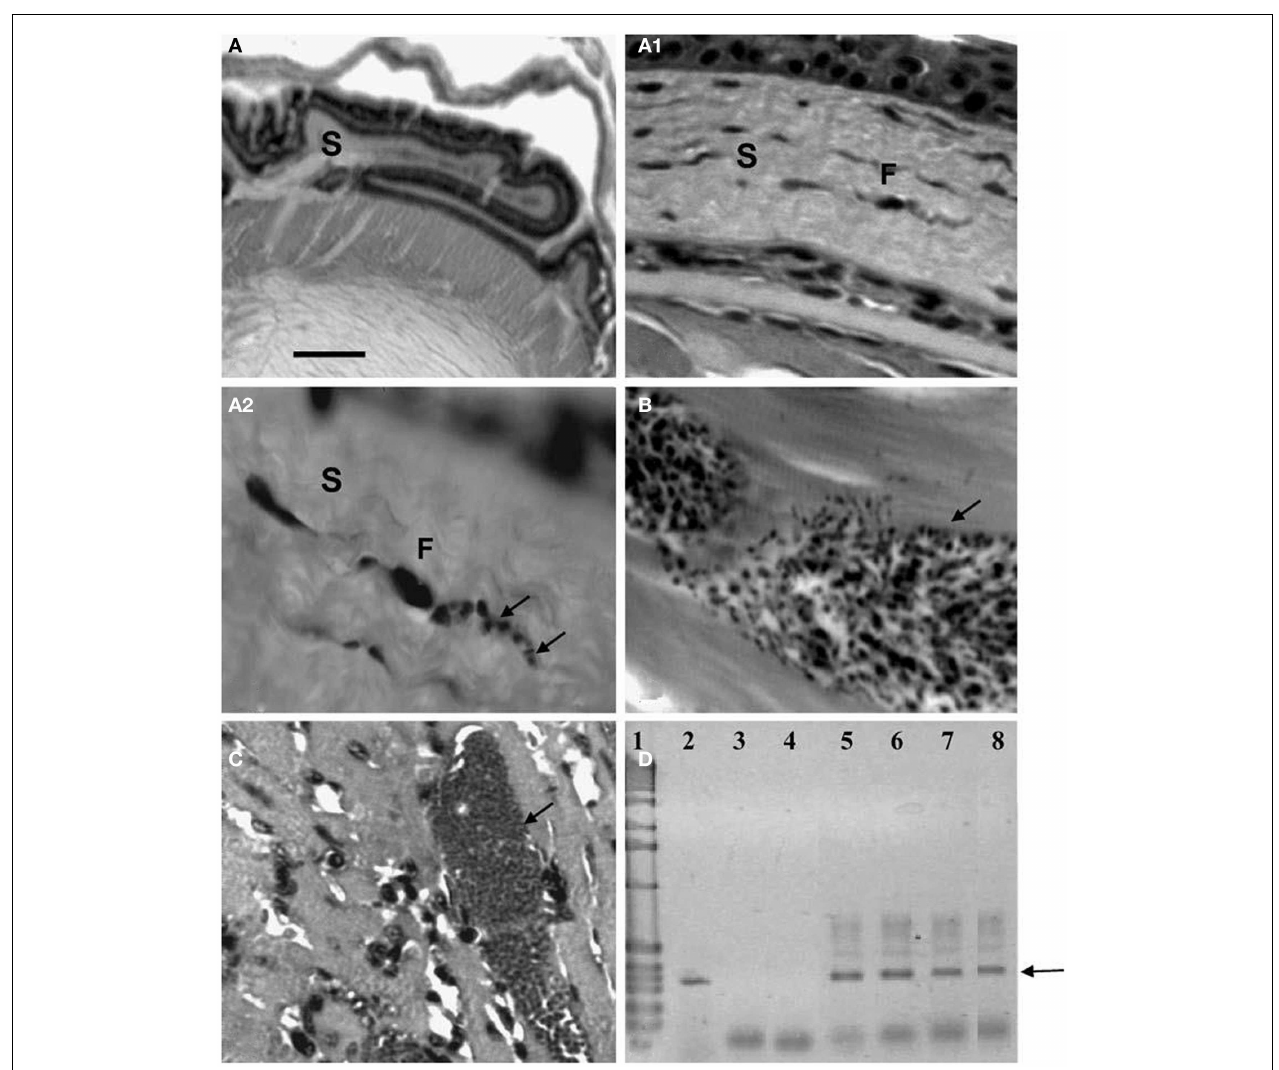
kDNA (arrow) extracted from ocular tissues of experimentally infected NMRI mice in 2.5% agarose gel electrophoresis (ethidium bromide stain): Lane 1 1-kb ladder molecular marker (Gibco BRL LifeTechnologies), lane 2 nude T. cruzi DNA, lane 3 negative PCR control, lane 4 MRAT/VE/1996/CO22 isolate, lane 5 MHOM/BR/1950/Y strain, lane 6 MHOM/VE/1970/EP isolate, lane 7 MDID/BR/1999/M1 isolate, and lane 8 MDID/VE/1995/CO79